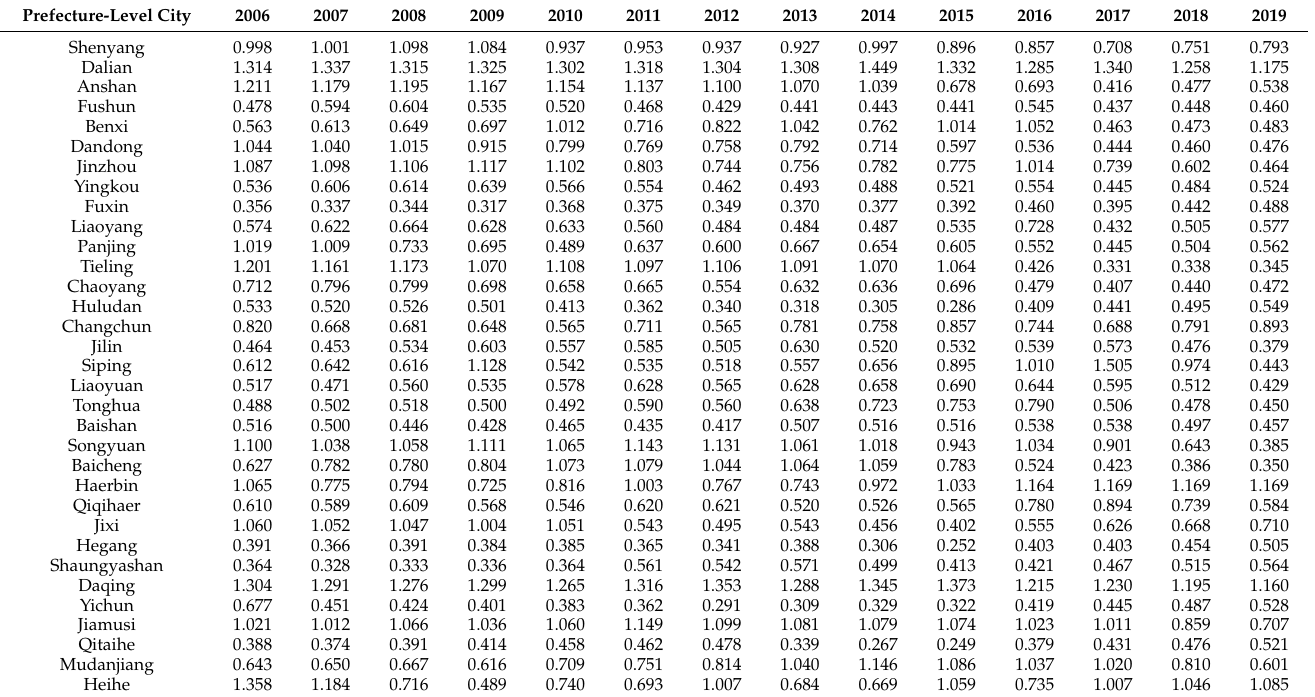
Table A1. CO 2 emission efficiency (CEE) in northeast China during the 2006–2019 period. Prefecture-Level City